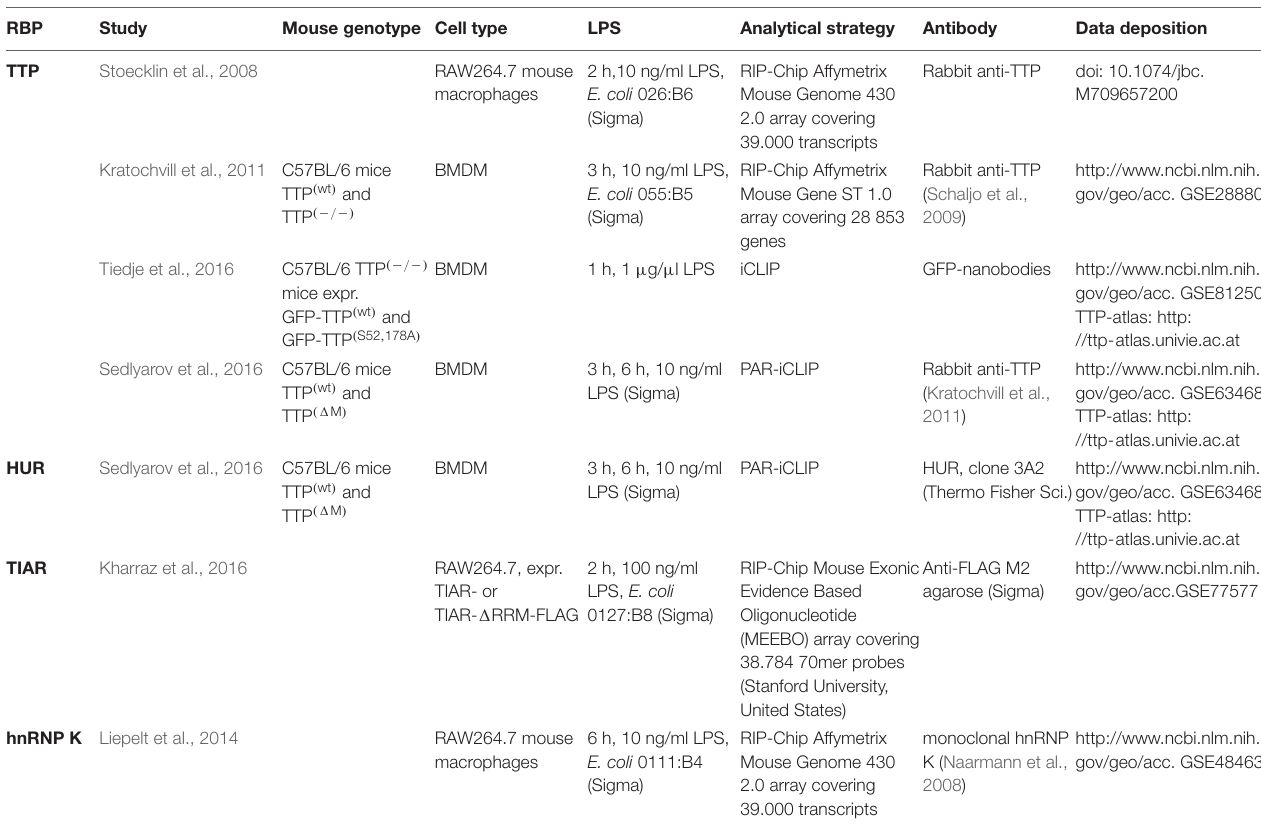
TABLE 1 | Experimental strategies, tools and conditions employed in the studies